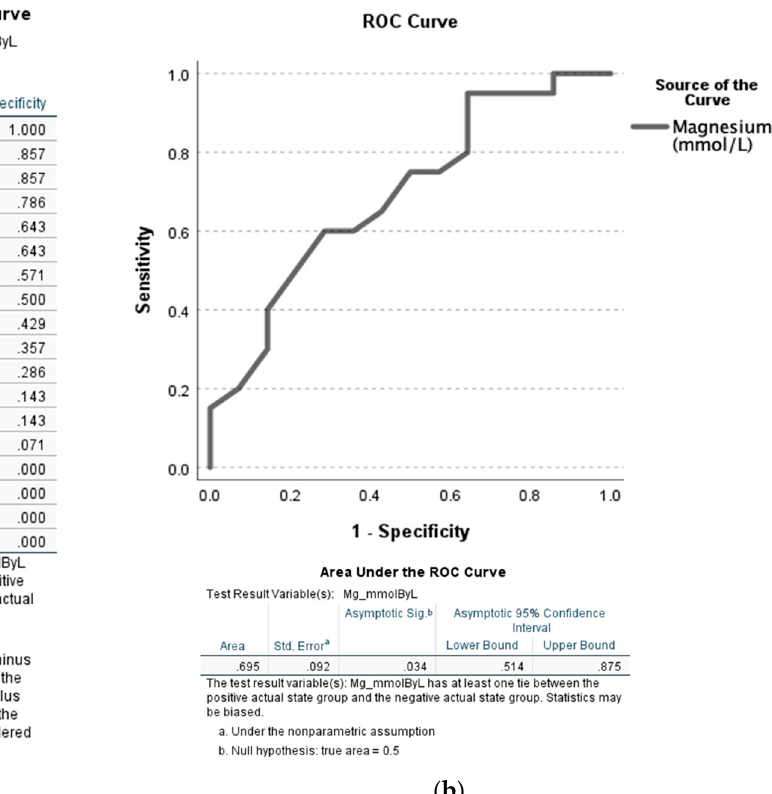
Figure 3. AUROC analysis of the serum magnesium levels (SMg [mmol/L]) among severe alcoholic hepatitis patients (MELD > 19) when compared to non-severe alcoholic hepatitis (MELD ≤ 19). ( a ) Coordinates of the ROC curve. ( b ) ROC curve with confidence interval (lower and upper bound) and area under the curve (area) provided at the bottom of the figure. Statistical significance was set at p < 0.05. Sensitivity describes the ability of this test to correctly identify severe AH patients with hypomagnesemia. 1-Specificity is the ability of this test to correctly identify the severe AH participants in this study with hypomagnesemia in the context of MELD scores.